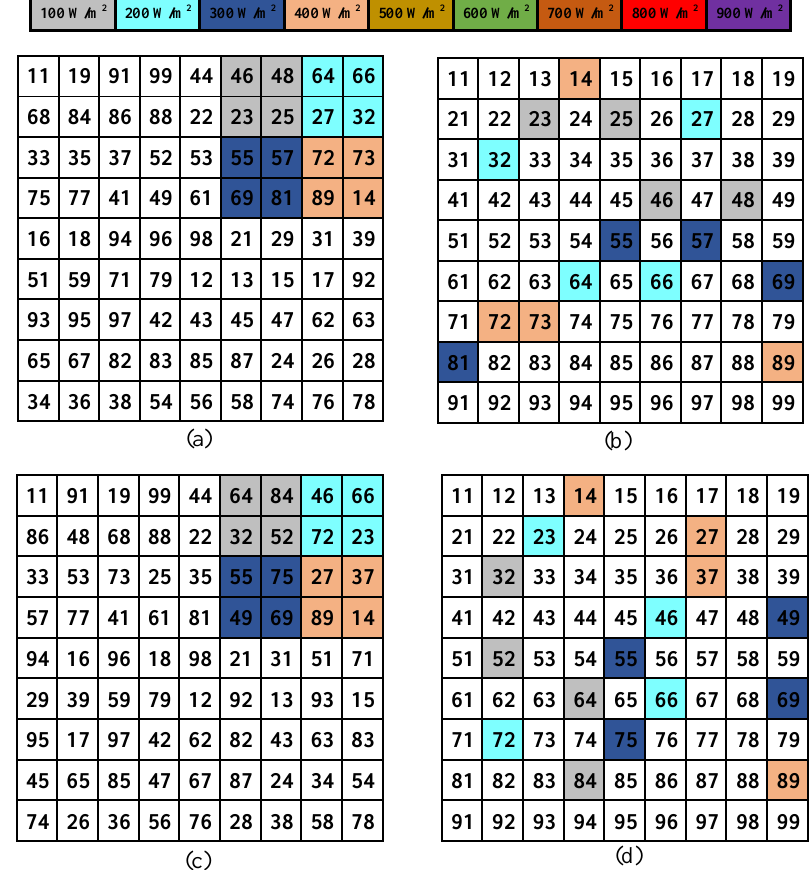
In Case-2, a 4 × 4 sub-array is subjected to partial shading condition at Top-Right as shown in Figure 4a.